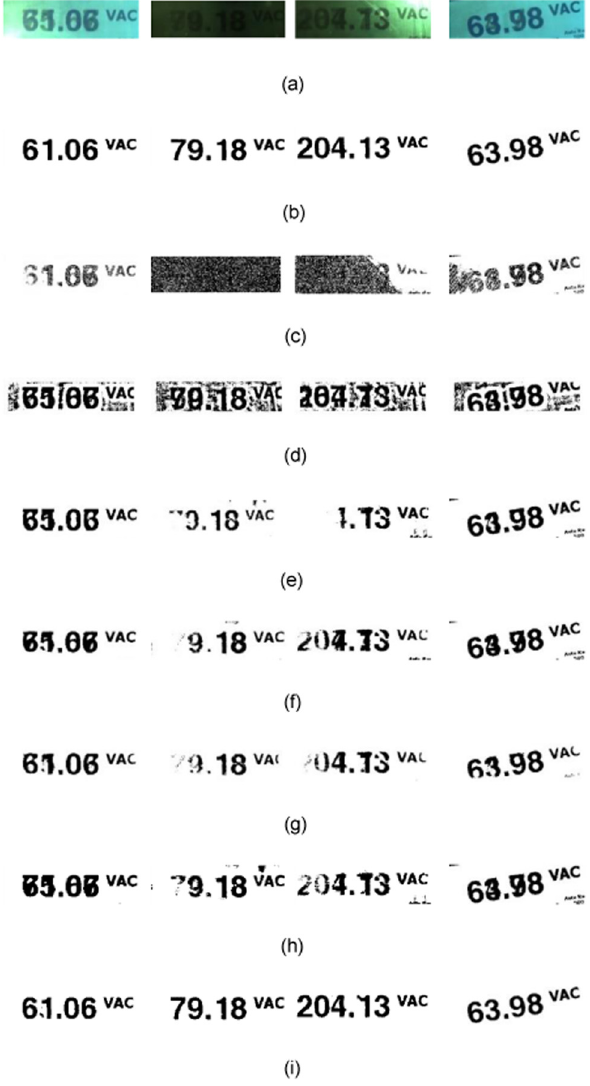
Figure 7: Processing results of di ff erent algorithms. ( a )